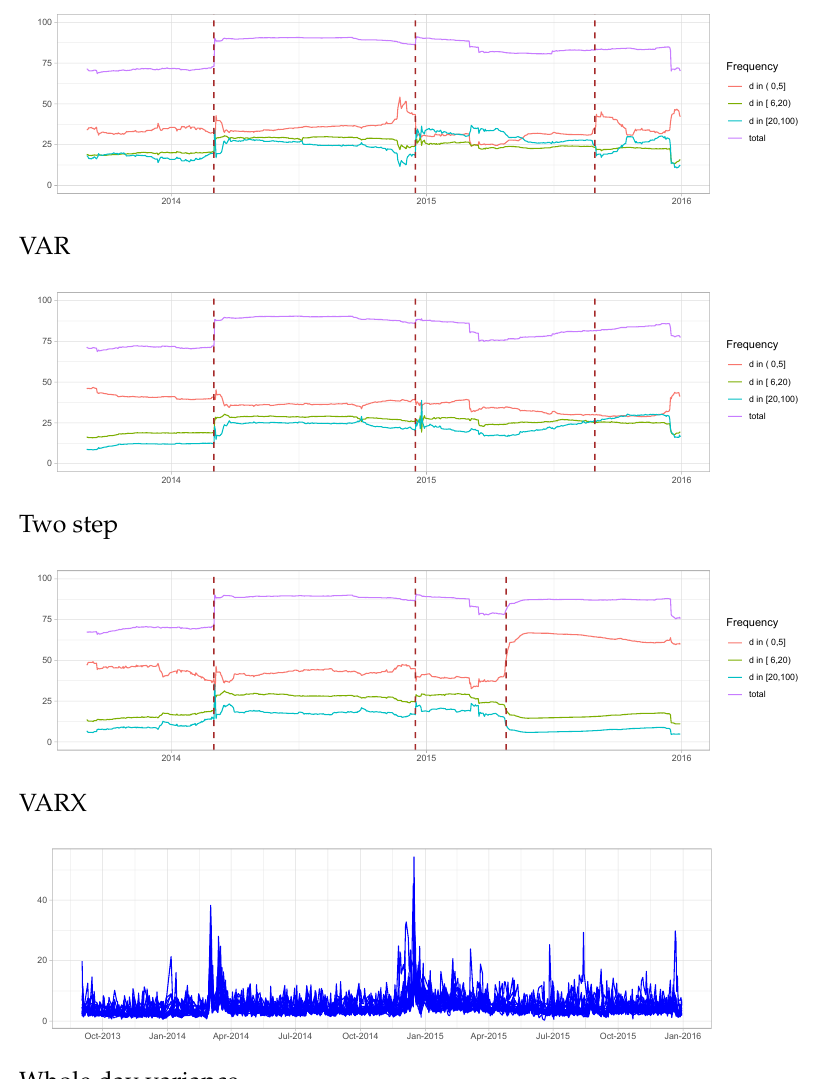
Figure 9. Dynamic frequency connectedness during